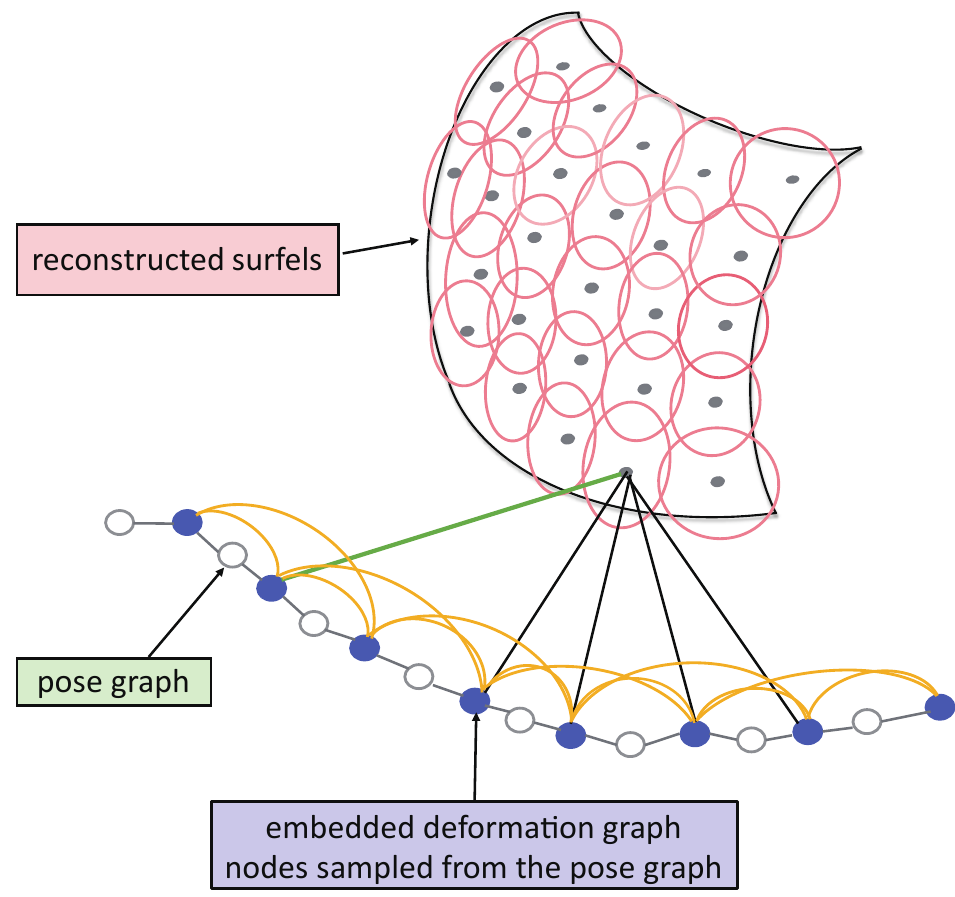
Figure 4. We build pose graph and embedded deformation graph in our system. The nodes of the embedded deformation graph are sampled from the pose graph. Each node is connected with its neighbors nearest in time. The surfels in the maps are associated with the nodes of the embedded deformation